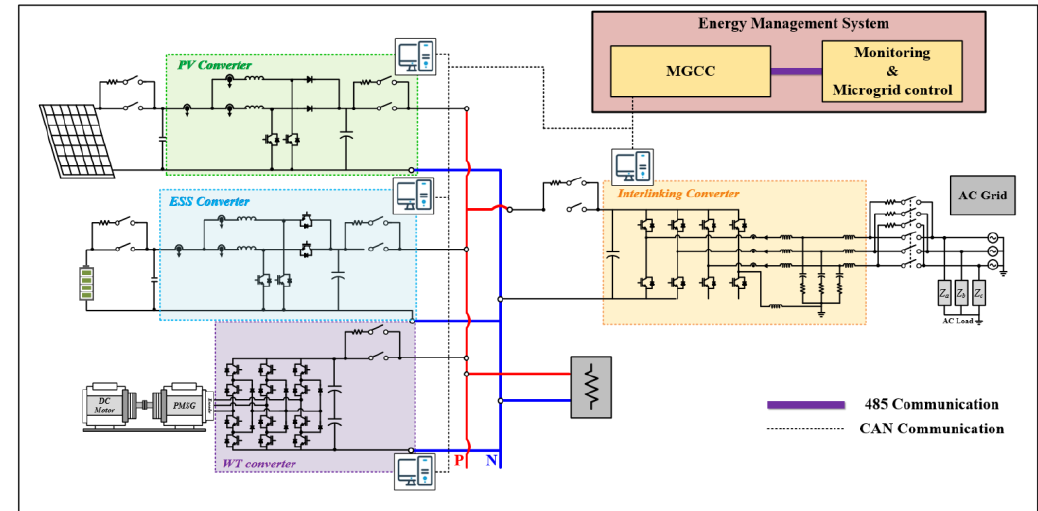
Figure 3. Configuration diagram of hybrid AC/DC distribution network.